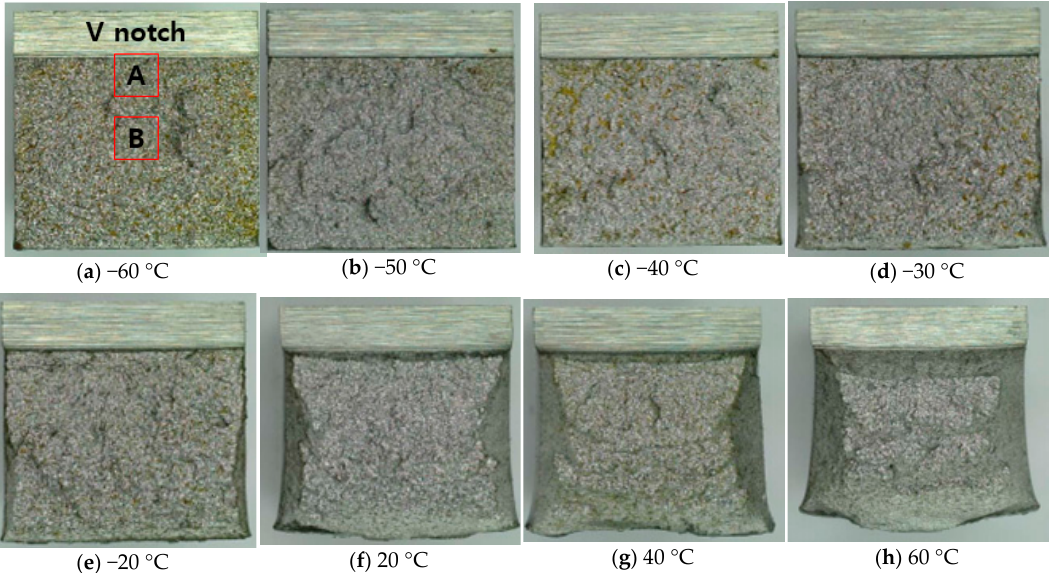
Figure 11. Images of the fracture surfaces taken with an optical microscope.